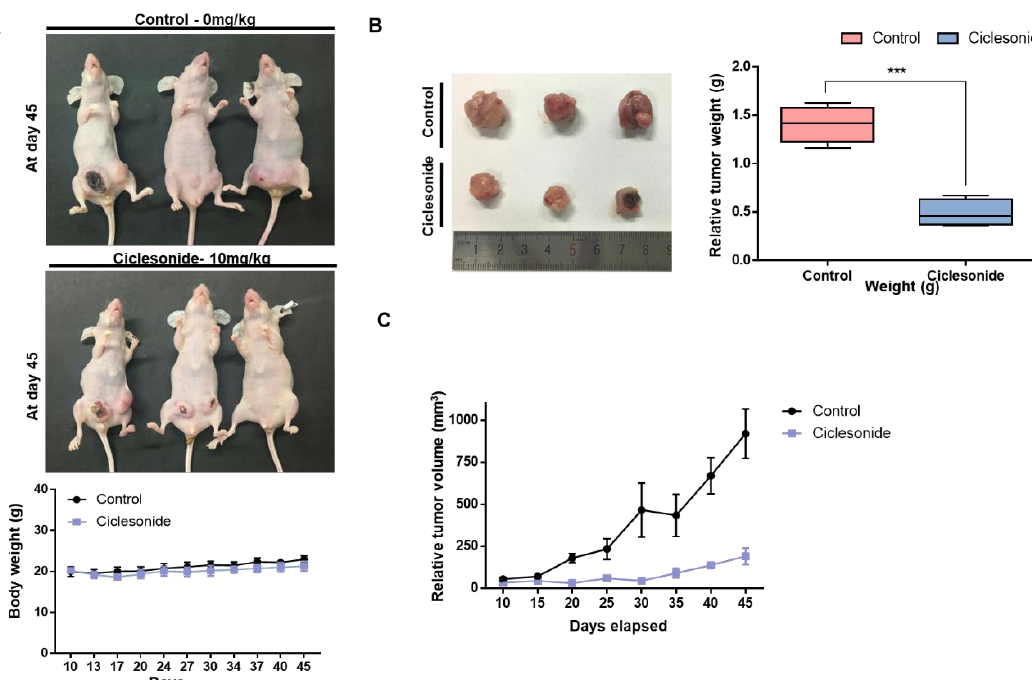
Figure 2. Ciclesonide reduces tumor growth in a mouse model. The 2 × 10 6 of breast cancer cells were injected into the mammary fat pads at nude mice. The inhibitory effect of ciclesonide on tumor growth in MDA-MB-231 tumor-bearing nude mice. ( A ) The effect of tumor growth with ciclesonide in the female nude mice containing breast cancer cells. The concentration of ciclesonide was 10 mg/kg. After 45 days, images were acquired. ( B ) Inhibitory effect of ciclesonide on the tumor weight. The nude mice were sacrificed on day 45, and tumors were weighed. Data from triplicate experiments are shown as the means ± SDs; *** p < 0.05 vs. the control. ( C ) The volumes of tumors from nude mice during the 45-day experimental period were comparable with those of tumors from control and ciclesonide-treated mice. Tumor volumes were calculated as follows: (width 2 × length)/2.